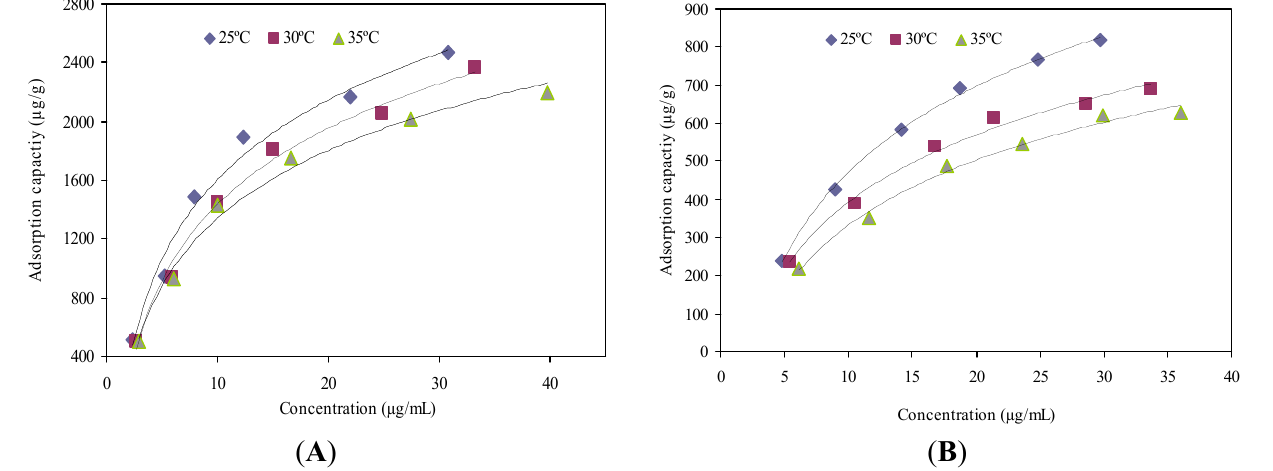
Figure 2. Adsorption isotherms of SP207 for ustiloxin A ( A ), SP207 for ustiloxin B ( B